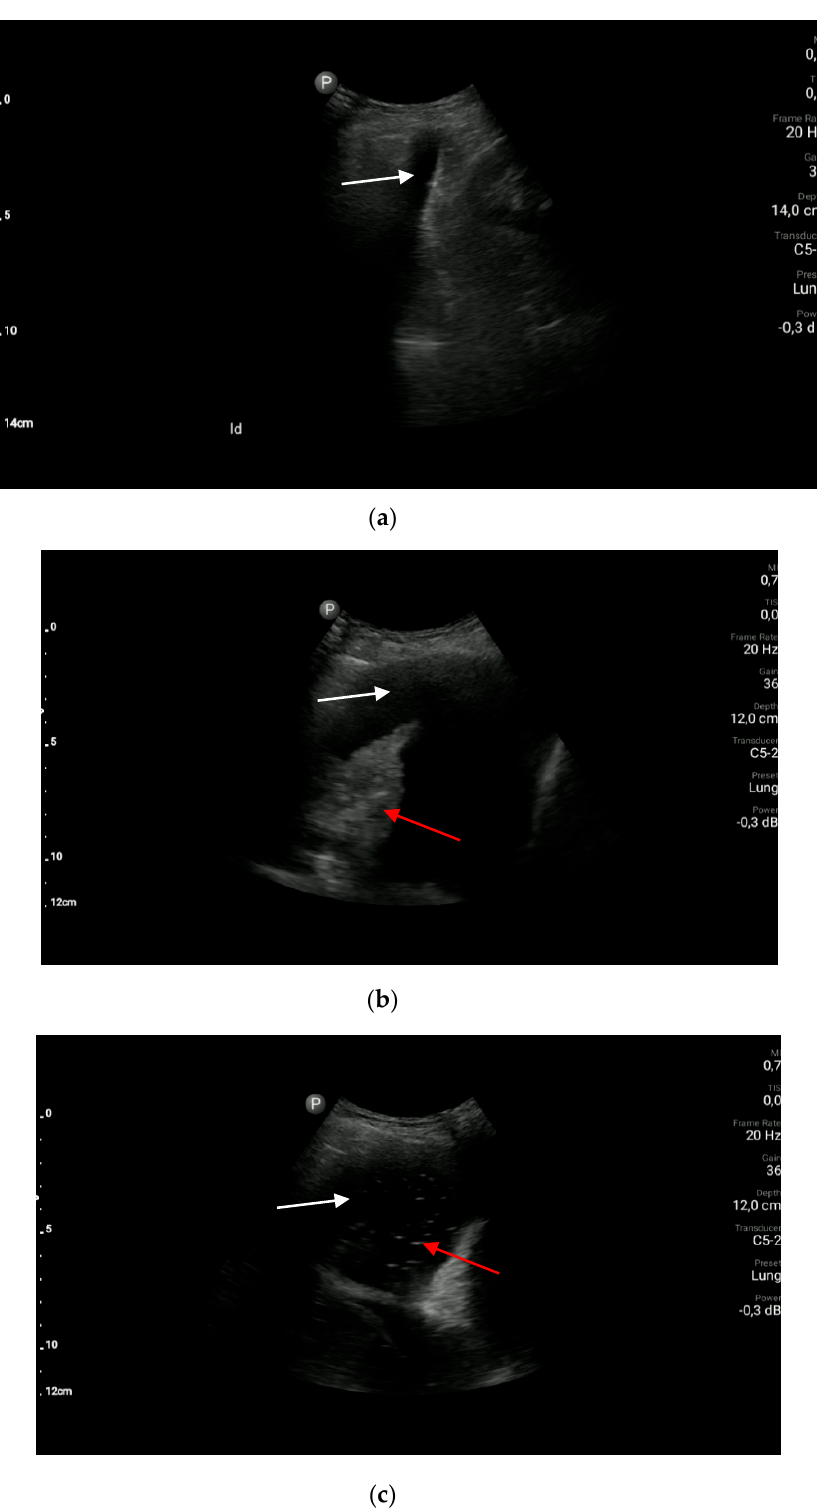
Figure 5. So called “white lung”, a significant number of B-lines which cannot be visualized separately (area between white arrows).